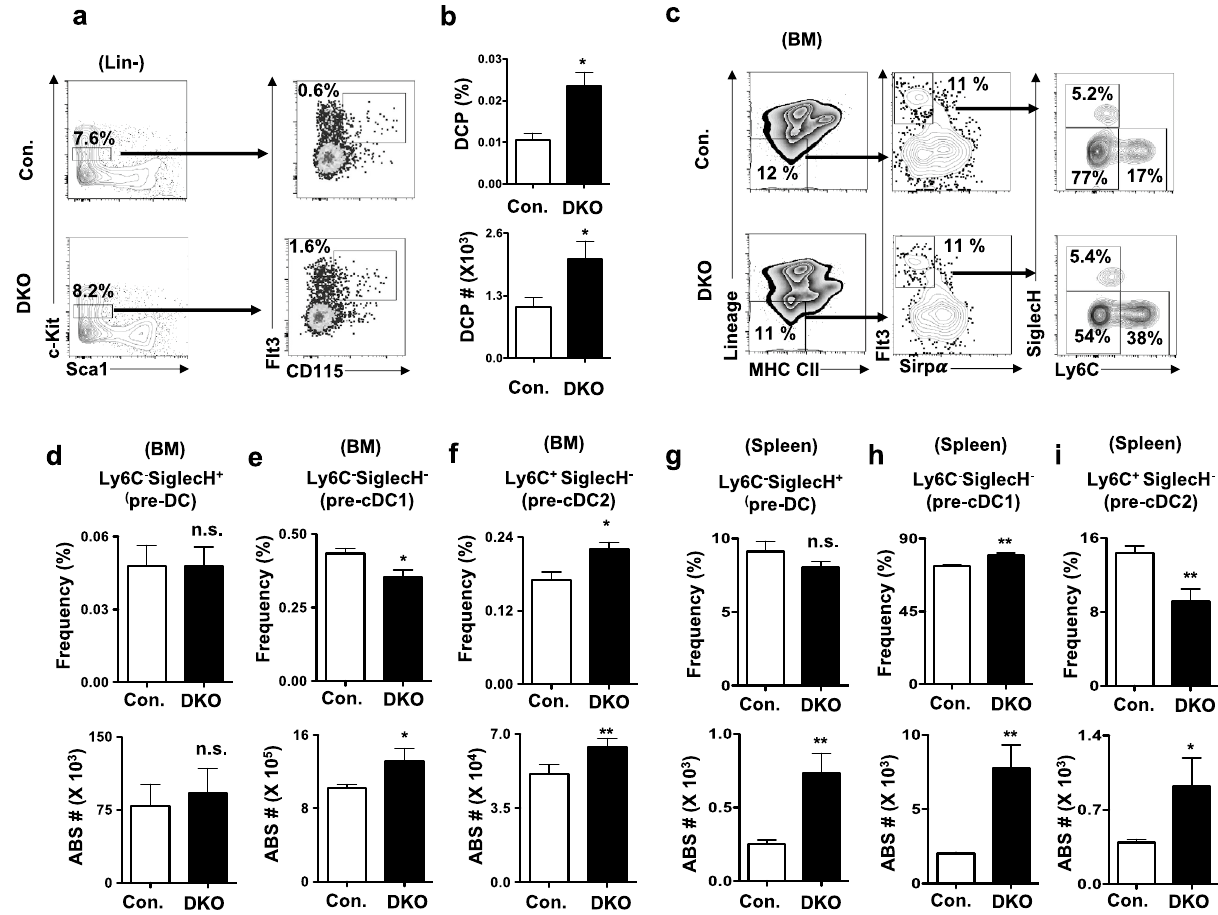
Figure 4. Deletion of p85 subunits affects early stages of DC differentiation. ( a ) FACS plots indicating frequencies of Lin − Sca1 − c-Kit int Flt3 + CD115 + CDPs in the BM of DKO and control mice. Cells were pre-gated on Lin − cells of the BM. Shown are the frequencies within the indicated gates. Data are representative of 3 independent experiments. ( b ) Frequencies (top) and absolute numbers (bottom) of CDPs in BM of DKO and control mice (n = 11). Indicated are the overall frequencies within the organ. ( c ) FACS plots indicating frequencies of Ly6C − SiglecH + (pre-DC), Ly6C − SiglecH − (pre-cDC1) and Ly6C + SiglecH − (pre-cDC2) subsets within Lin − CII − Flt3 + Sirpα − fraction in the BM of DKO and control mice. Shown are the frequencies within the indicated gates. Data are representative of 3 independent experiments. ( d – f ) Frequencies (top) and absolute numbers (bottom) of Ly6C − SiglecH + (pre-DC) ( d ), Ly6C − SiglecH − (pre-cDC1) ( e ) and Ly6C + SiglecH − (pre- cDC2) ( f ) subsets within Lin − CII − Flt3 + Sirpα − fraction in the BM of DKO and control mice (n = 11). Indicated are the overall frequencies within the organ. ( g – i ) Frequencies (top) and absolute numbers (bottom) of Ly6C − SiglecH + pre-DC ( g ), Ly6C − SiglecH − pre-cDC1 ( h ) and Ly6C + SiglecH − pre-cDC2 ( i ) subsets within Lin − CII − Flt3 + Sirpα + fraction in the spleen of DKO and control mice (n = 11). Indicated are the frequencies within the parent gates. Data represent mean and s.e.m. Two-tailed student’s t tests were used to assess statistical significance (* P < 0.05, ** P < 0.01, n.s. P >